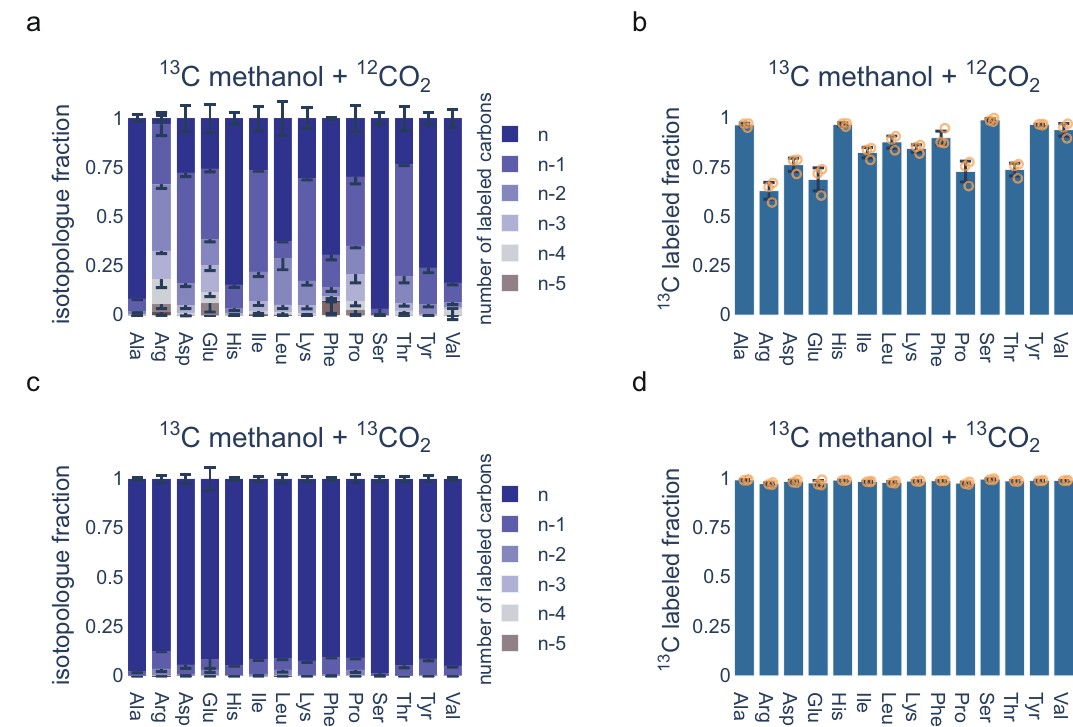
Fig.4|Methanolincorporationintoprotein-boundaminoacidsbytheevolved methylotrophic E . coli strain. MEcoli_ref_1 was grown in minimal medium sup- plementedwith500mM 13 CmethanoleitherunderambientCO 2 ( a , b) orunder5% (V/V) enriched 13 CO 2 atmosphere ( c , d ) Antibiotics, IPTG and EDTA were dropped out of the minimal medium to ensure that methanol and CO 2 were the only avail- able carbon sources. Isotopologue distributions and fractional contributions were